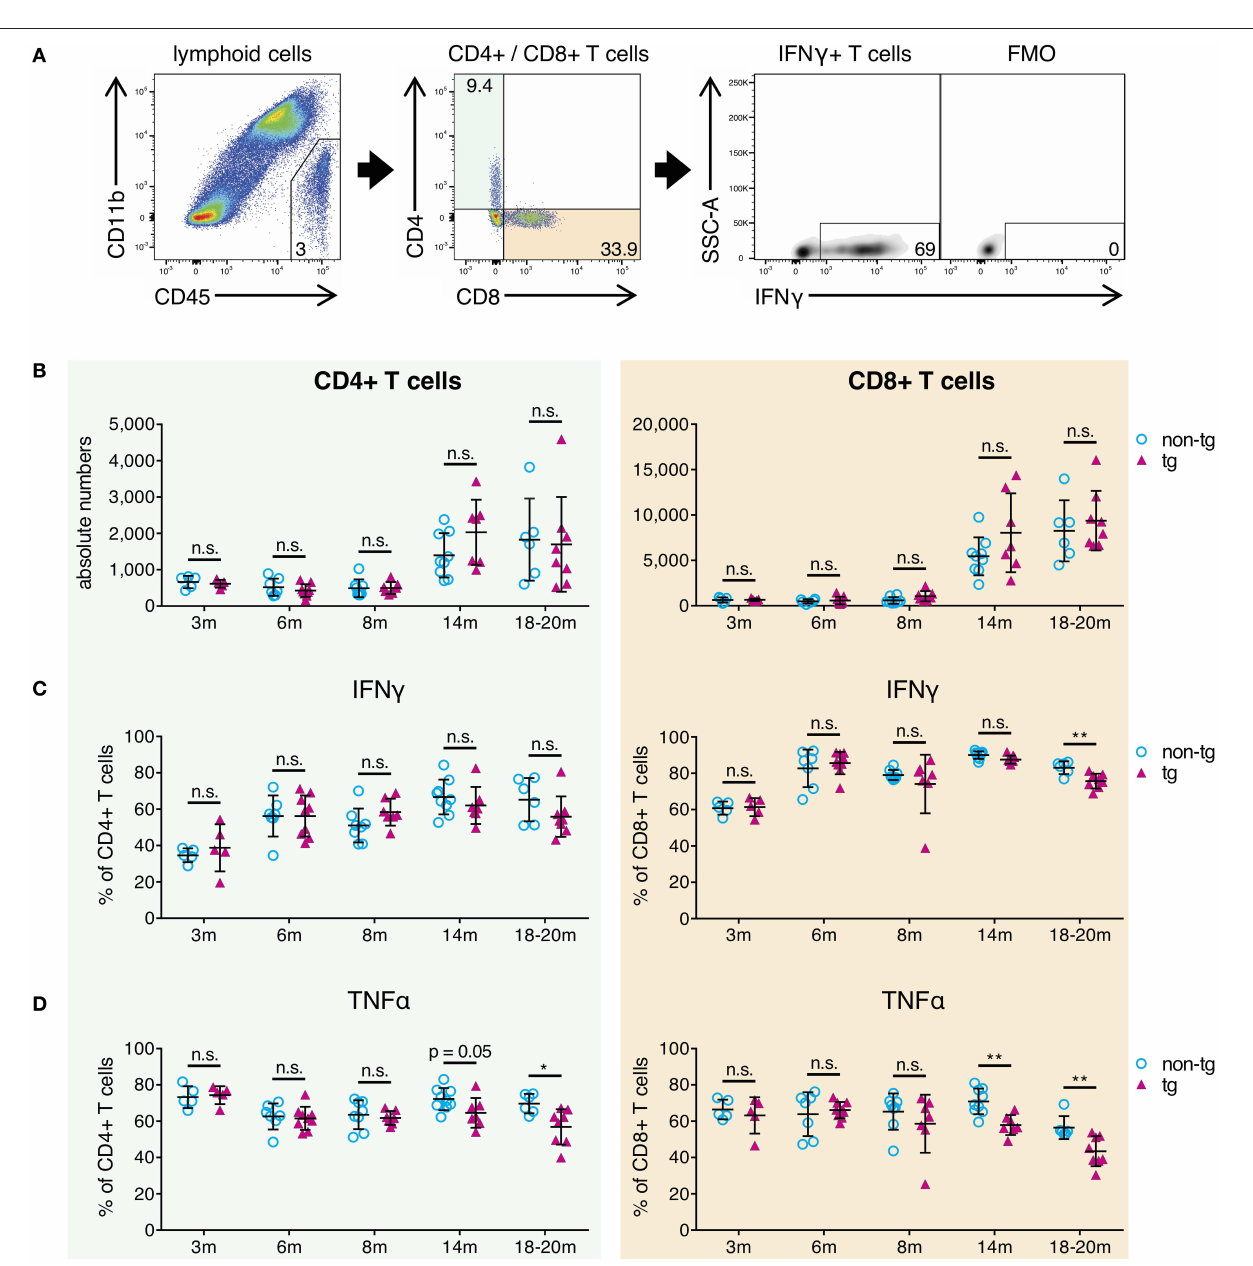
( Figure S5G ). These results indicate that A β 1-42 oligomers might not act on T-cells directly, but most probably exert their action on antigen-presenting